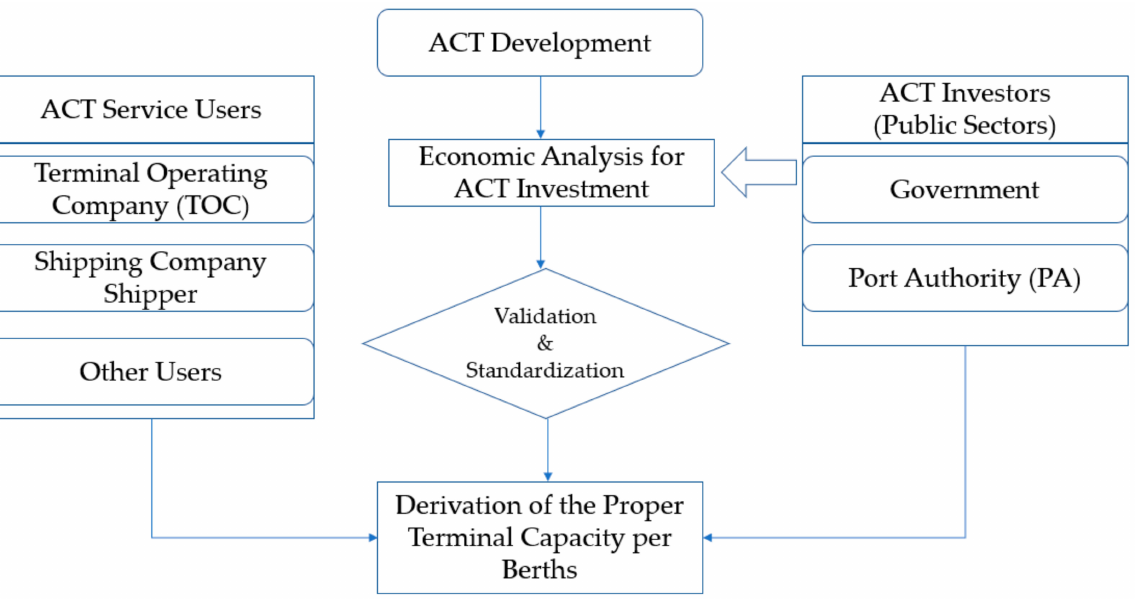
Figure 1. Research structure (Source: